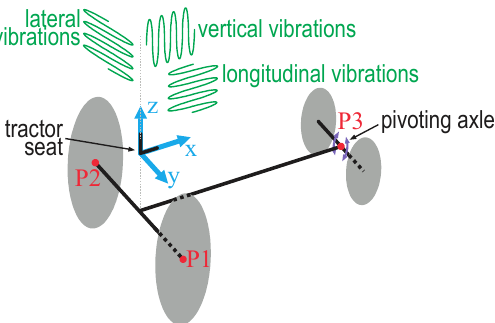
Figure 1. Scheme of a tractor that shows the coordinate axis used in this study (blue), the three points P1, P2 and P3 at which the chassis is attached to the tractor (red), the rotation capacity of the front axle (violet), and the spatial movement of the lateral, vertical and longitudinal vibrations (green).